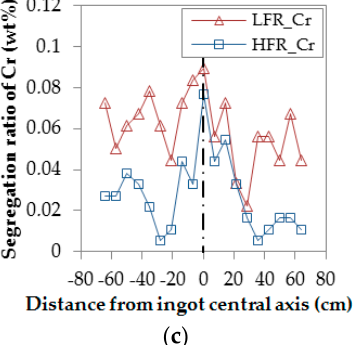
Figure 5. Segregation ratio profiles along the bottom of the cutting section of the two ingots: ( a ) carbon; ( b ) manganese; ( c ) chromium.